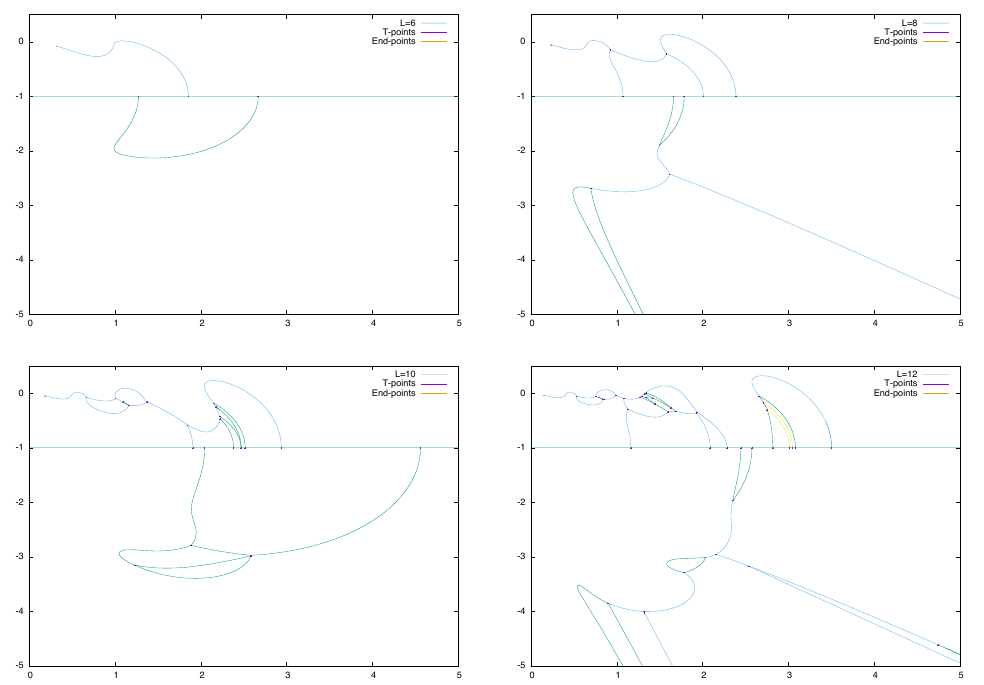
Figure 8 . Condensation curves for partition function zeros on a (2 M + 1) (cid:2) 2 N cylinder, in the limit M ! 1 (closed channel), for a system exhibiting only spin-zero symmetry. The panels show, in reading direction, the cases N = 3 ; 4 ; 5 ;